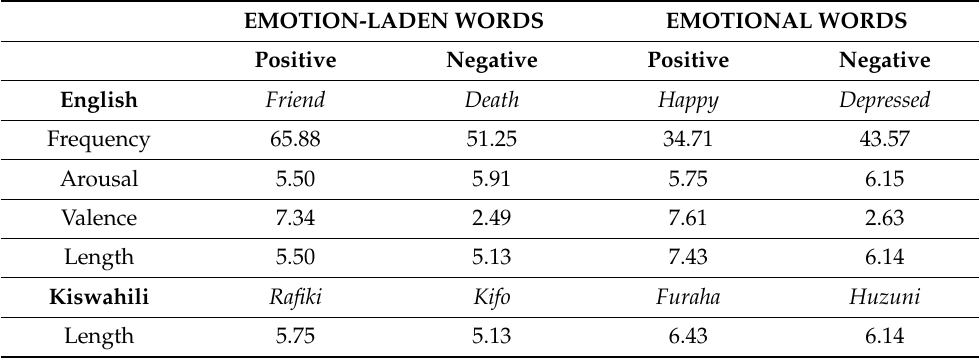
Table 2. Attributes for the word stimuli used in the Affective Simon